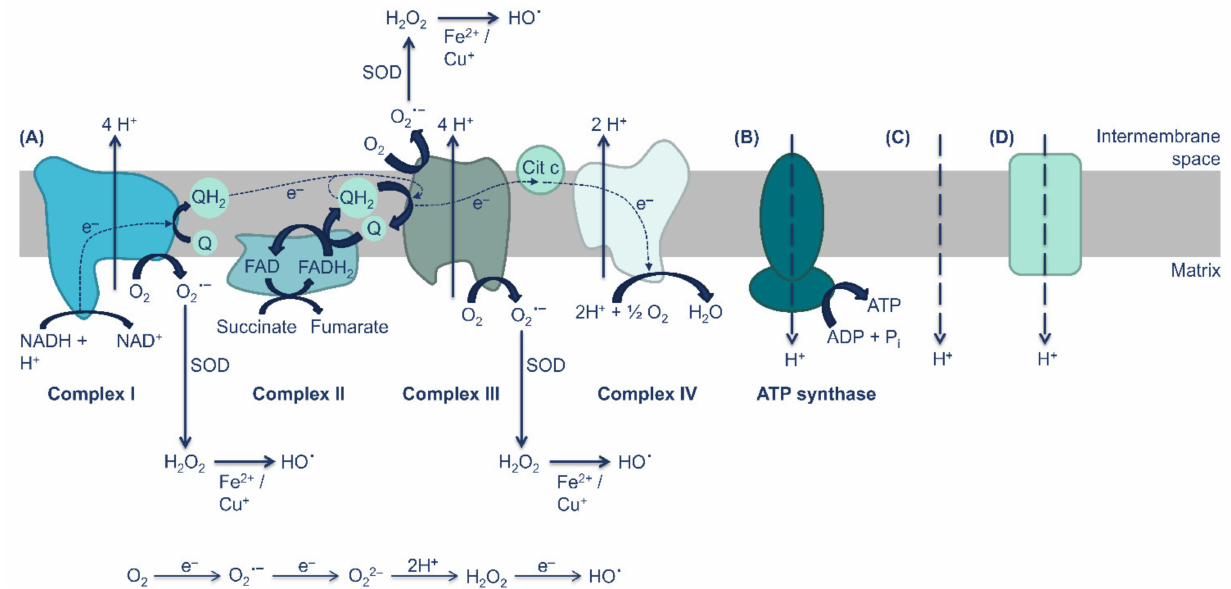
Figure 1. Proton transport and formation of ROS during oxidative phosphorylation. (A) In complex I, the oxidation of NADH (generated through glycolysis, β -oxidation, and Krebs cycle) to NAD + transfers two electrons to the complex. Complex I will then transfer the electrons to the quinone reservoir by reducing ubiquinone to ubiquinol. In complex II occurs the oxidation of succinate to fumarate, a reaction that reduces FAD to FADH 2 . FADH 2 also gives two electrons to ubiquinone, originating FAD and ubiquinol. Ubiquinol is released into the quinone reservoir, joining those from NADH. Ubiquinol transports electrons trough the intermembrane space to complex III, where they are again oxidized to quinones. Complex III transfers electrons to cytochrome c, which moves to complex IV. Complex IV receives the electrons from cytochrome c and transfers them to molecular oxygen, reducing it to water. Same electrons escape to oxygen, which lead to the formation of superoxide anions. Superoxide leads to a cascade of redox reactions, which leads to the formation of other ROS, such as the hydroxyl radical ( • OH) and hydrogen peroxide (H 2 O 2 ). During the transport of electrons through the respiratory chain, protons are pumped from the matrix into the intermembrane space by complexes I, II, and IV. This action creates an electrochemical gradient that is used to (B) convert ADP into ATP, by ATP synthase. The proton transport to the mitochondrial matrix can be also made through (C) basal proton leak or (D) inducible proton